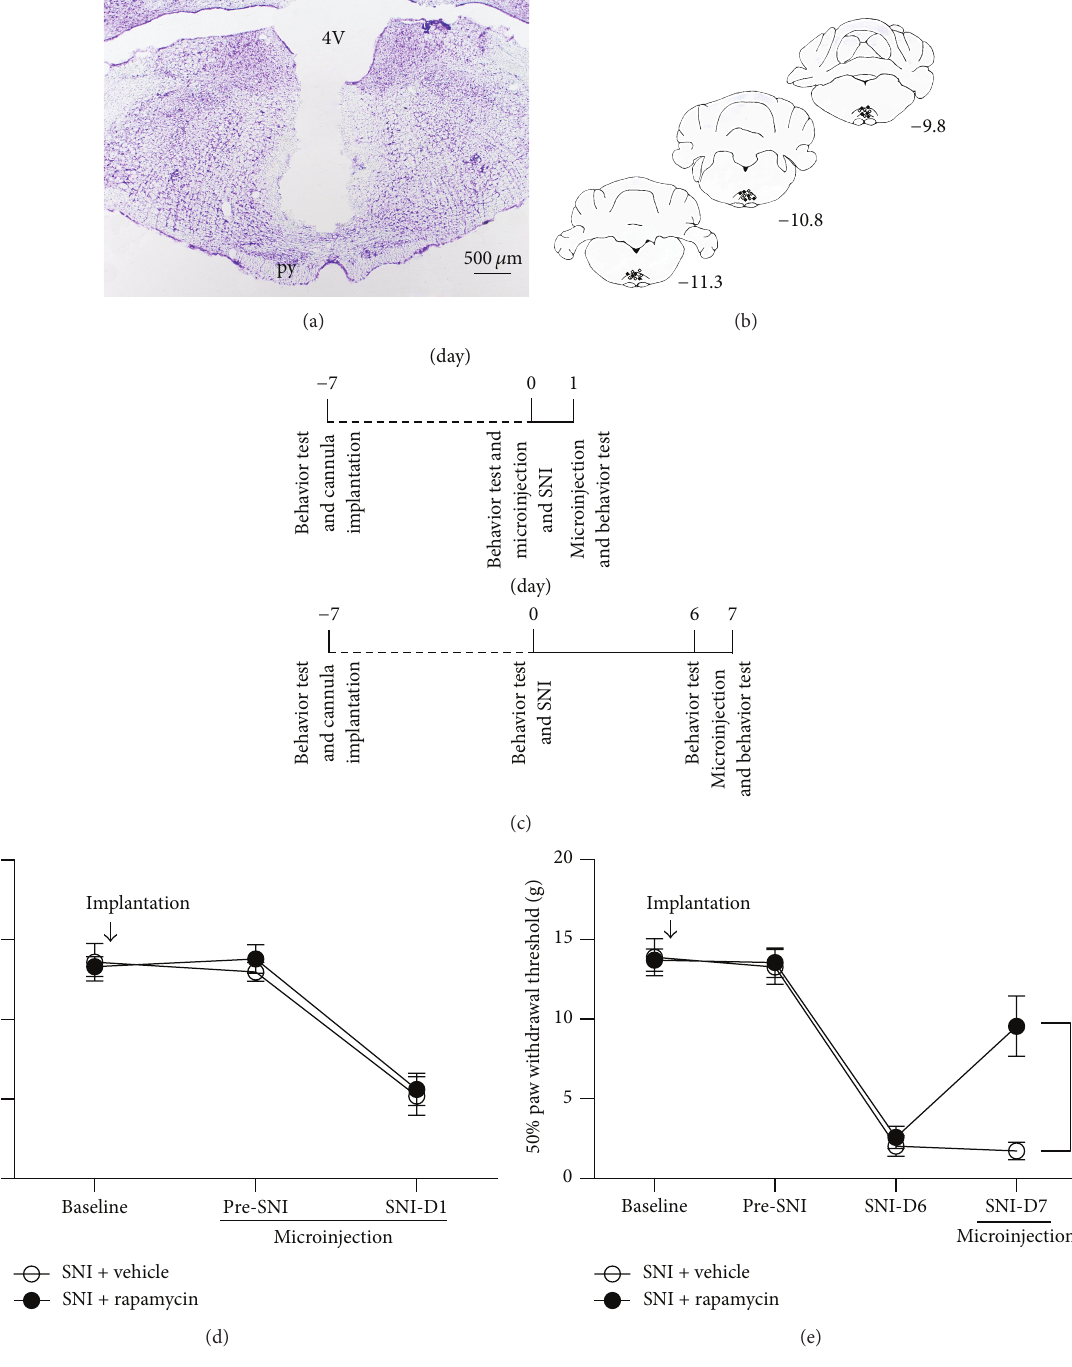
Figure 6: Intra-RVM microinjection of the mTOR inhibitor rapamycin (250 𝜇 M) partially reversed established mechanical allodynia (maintenance stage) but showed no effect on the induction stage of SNI-induced neuropathic pain in rats. (a) Representative Nissl-stained section showing injection sites within the RVM (4V: 4th ventricle; py: pyramidal tract). Scale bar = 500 𝜇 m. (b) Camera lucida drawings showing the cannula tip placements in rats injected with rapamycin (black circles, 𝑛 = 14 ) or vehicle (white circles, 𝑛 = 14 ) in the RVM. The numbers correspond to the distance in millimeters (mm) posterior to bregma in the brain. (c) Experimental schedule. The behavioral tests, cannula implantation, microinjection, and SNI surgery were performed as indicated in the schedule. (d) Intra-RVM microinjection of rapamycin (250 𝜇 M) before SNI (Pre-SNI) and 1 day after SNI (SNI-D1) could not alleviate mechanical allodynia 30 min after the SNI- D1 injection compared to vehicle injection ( 𝑛 = 7 rats/group). (e) Microinjection of rapamycin (250 𝜇 M) into the RVM 30min before the behavioral test significantly reduced mechanical allodynia at 7 days after SNI (SNI-D7) compared to vehicle injection ( ∗∗ 𝑃 < 0.01 , 𝑛 = 7